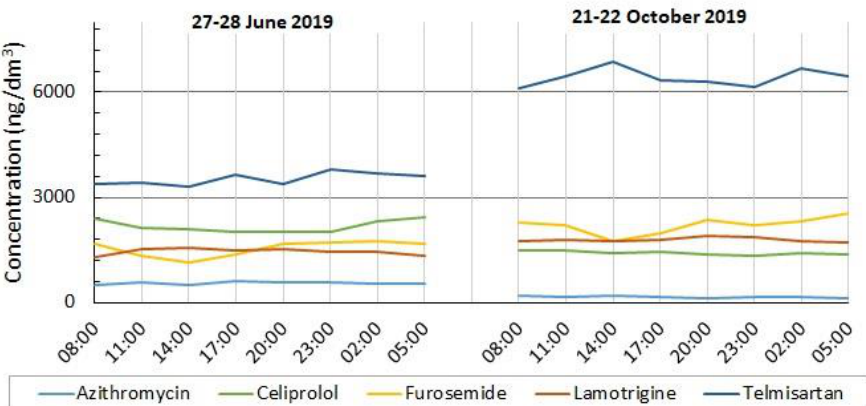
Figure 8. Water quality of the Hnevkovice WWTP effluent: azithromycin, furosemide, lamotrigine, telmisartan, celiprolol.